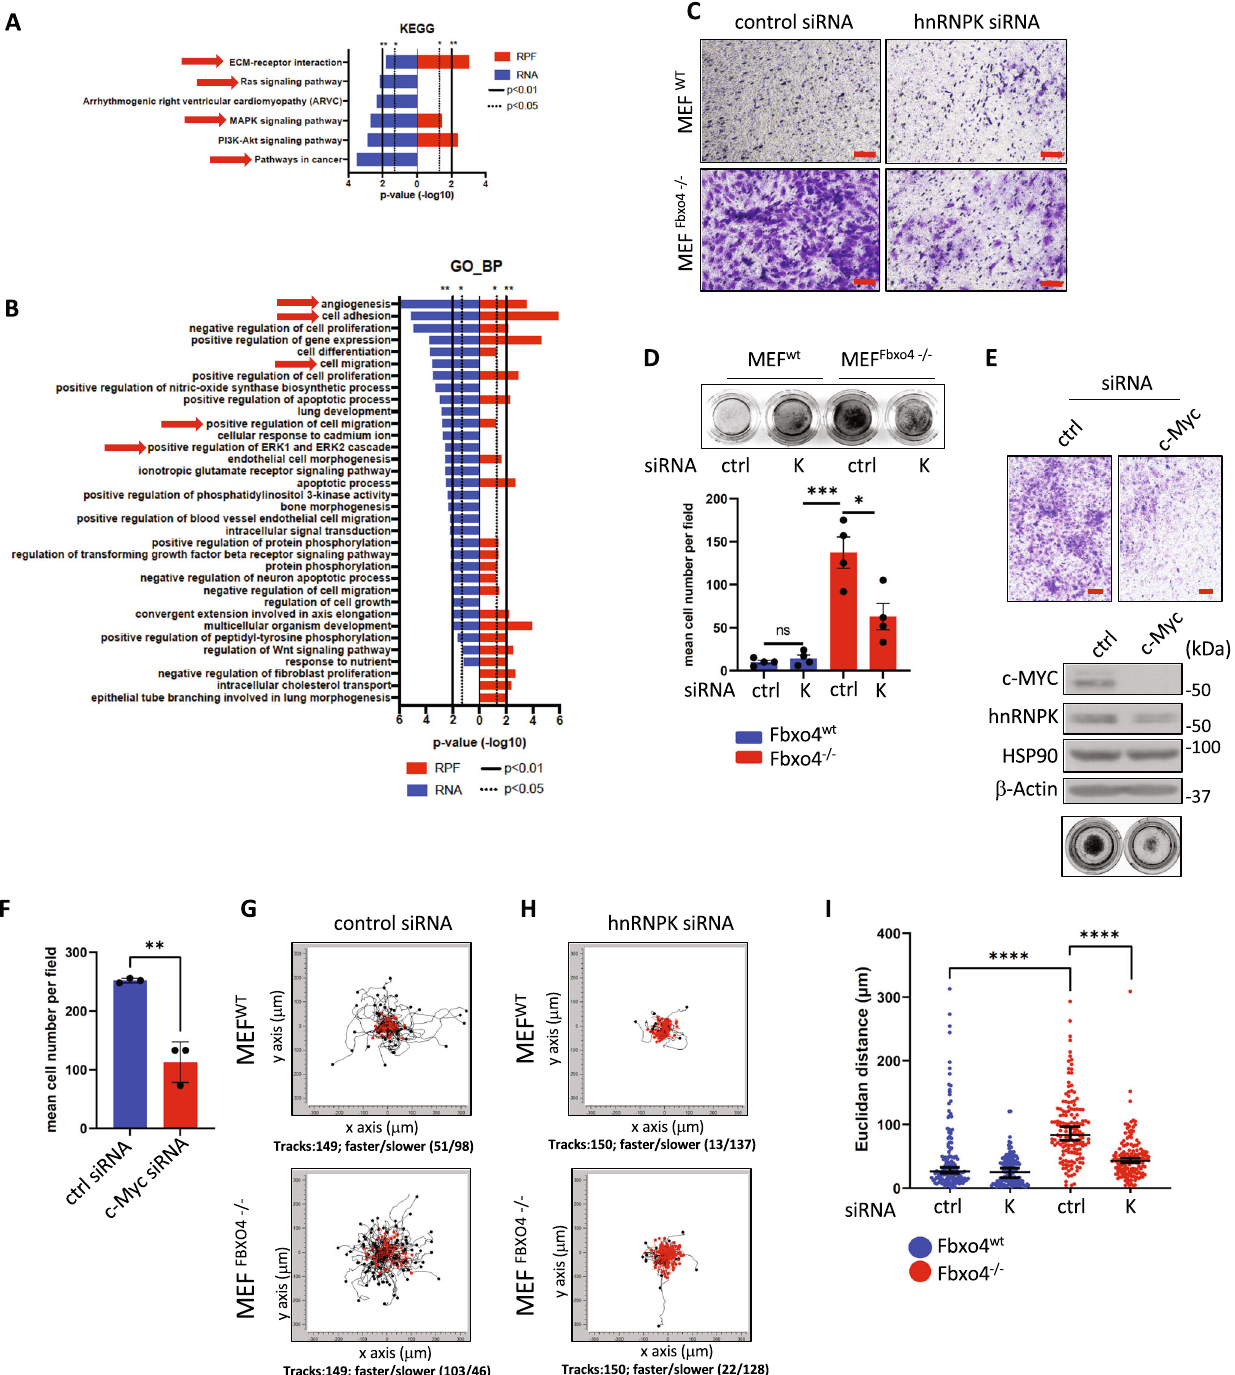
G , H present tracks of individual cells in cell tracking assay. Red paths indicate on cells moving <0.25 μ m/min I Quanti fi cation of motility in covered Euclidean dis- tance. The data from invasion experiments ( D , F ) represents mean±SD and was analyzedbytwo-tailedStudent ’ s t test( D — n =4, F — n =3).Incellmotilityassay,149/ 150cellsweretrackedperconditioninthreebiologicallyindependentexperiments (49 or 50 cells/experiment). Data represents median with 95% CI and were com- paredbytwo-tailedStudent ’ s t test.* p <0.05,** p <0.01,*** p <0.001,**** p <0.0001. Scale bars C , E — 100 μ m. Exact p values from up to down: D p =0.0006, p =0.026, p =0.3892; F p =0.0023; ( I ) p =<0.0001 (both).